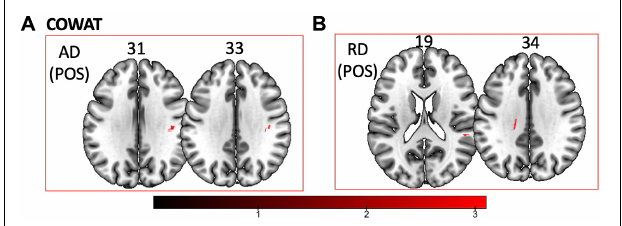
FIGURE 3 | Significant correlations between SFT scores and AD values ( p < 0.05, cluster-wise FDR corrected for multiple comparisons). Pictures are in neurological convention with left side in the figure corresponding to the left side of the brain.